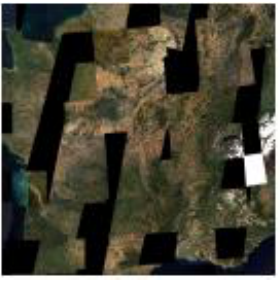
Figure 9 . Mosaic of a subset of the Sentinel-2 images downloaded.